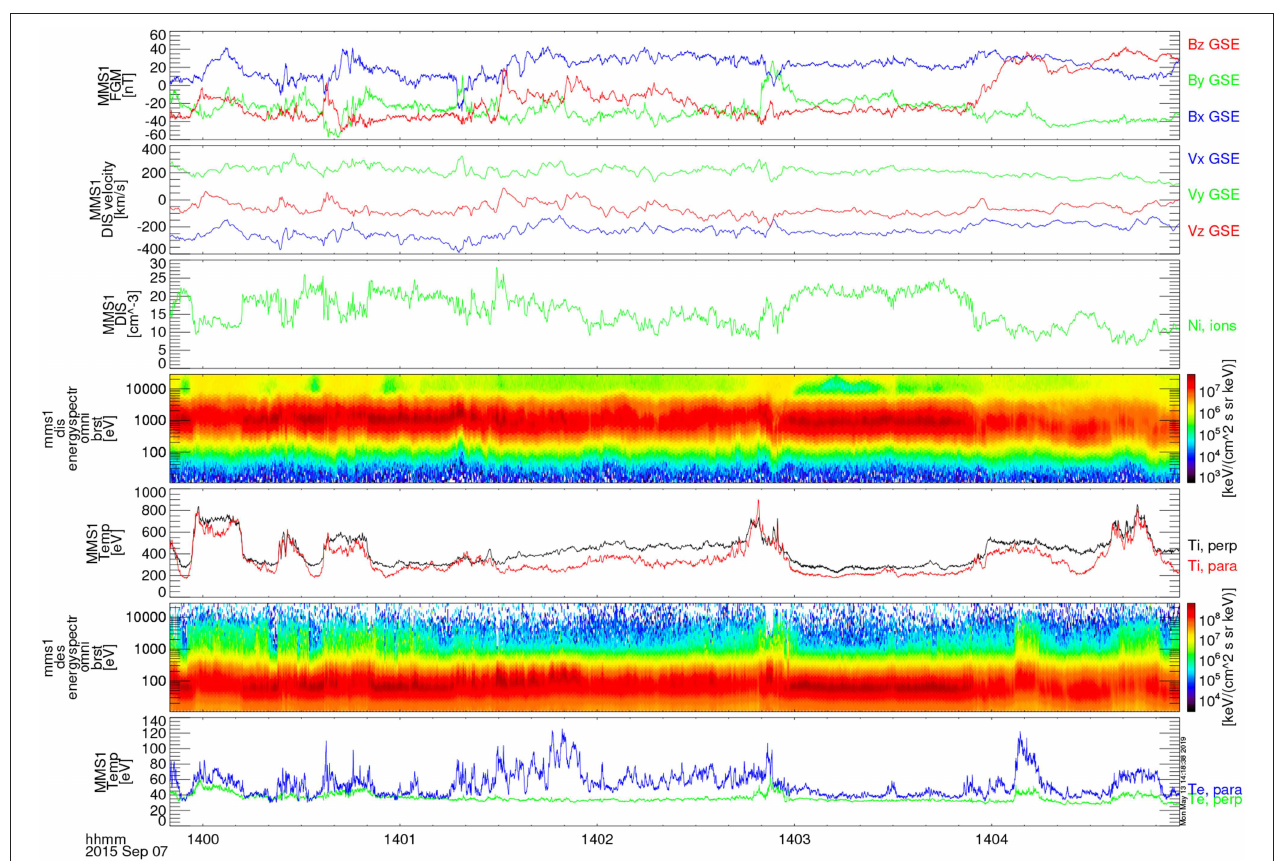
FIGURE 1 | Measured magnetic and plasma parameters from MMS, showing the magnetic field from the fluxgate magnetometer, the ion velocity from FPI DIS, the ion density the ion energy spectrogram, the ion parallel and perpendicular temperatures, the electron spectrogram and the electron parallel and perpendicular temperatures.